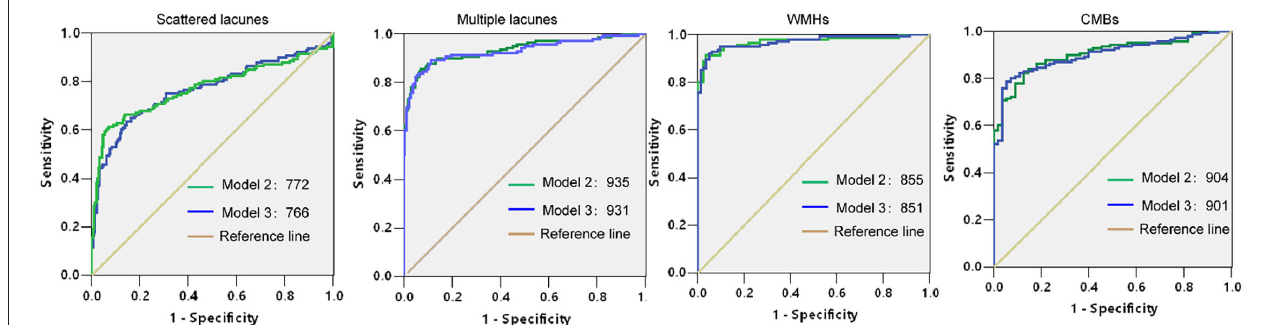
FIGURE 8 | Receiver operating characteristics (ROCs) and AUCs of models 2 and 3 in subtypes of CSVD.